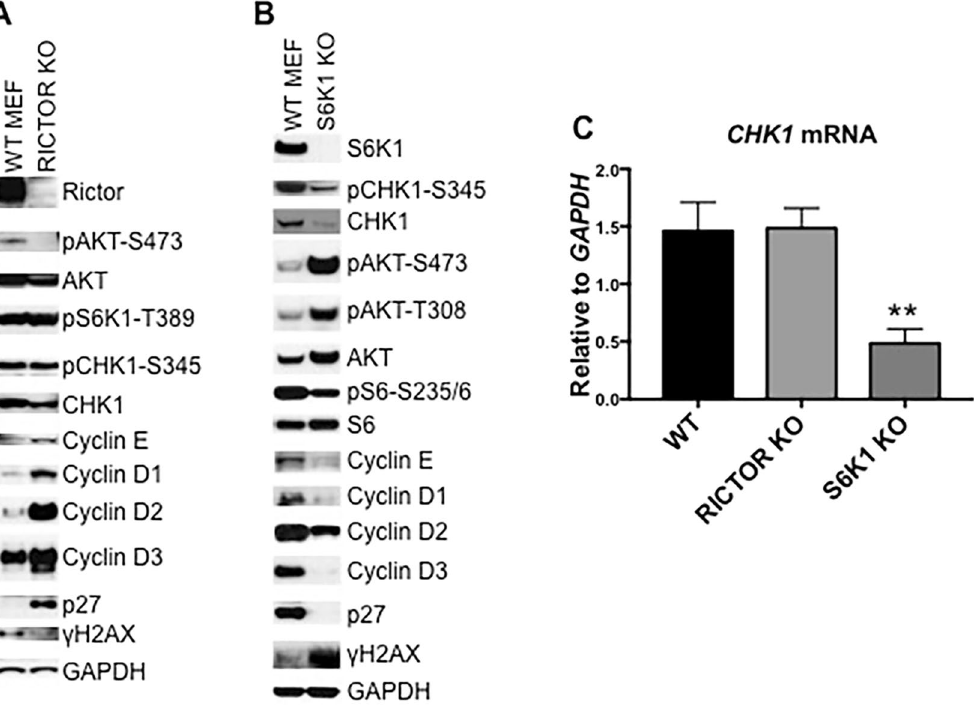
Figure 6. mTORC1-S6K1 Signaling Controls CHK1 via RB-E2F. ( A ) Total proteins of wild type (WT MEF) and RICTOR knockout (RICTOR KO) MEF cells were extracted for immunoblotting. ( B ) Total proteins of wild type (WT MEF) and p70S6K1 knockout (S6K1 KO) MEF cells were extracted for immunoblotting. ( C ) The total mRNA from Wild type (MEF WT), RICTOR KO, and S6K1 KO MEF cells was extracted to detect mouse CHK1 mRNA by real-time RT-PCR with GAPDH as internal control. Relative quantity of CHK1 mRNA was plotted. Error bars: Mean ± SD (n = 3). ** P < 0.01. Immunoblots were converted to gray with auto tone by Photoshop